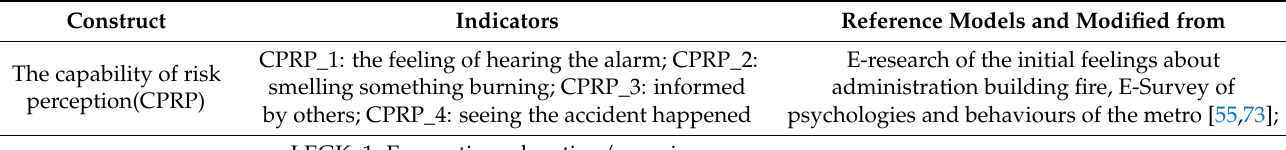
Table 1. Construction of predictive indicators for evacuation behaviour strategies.